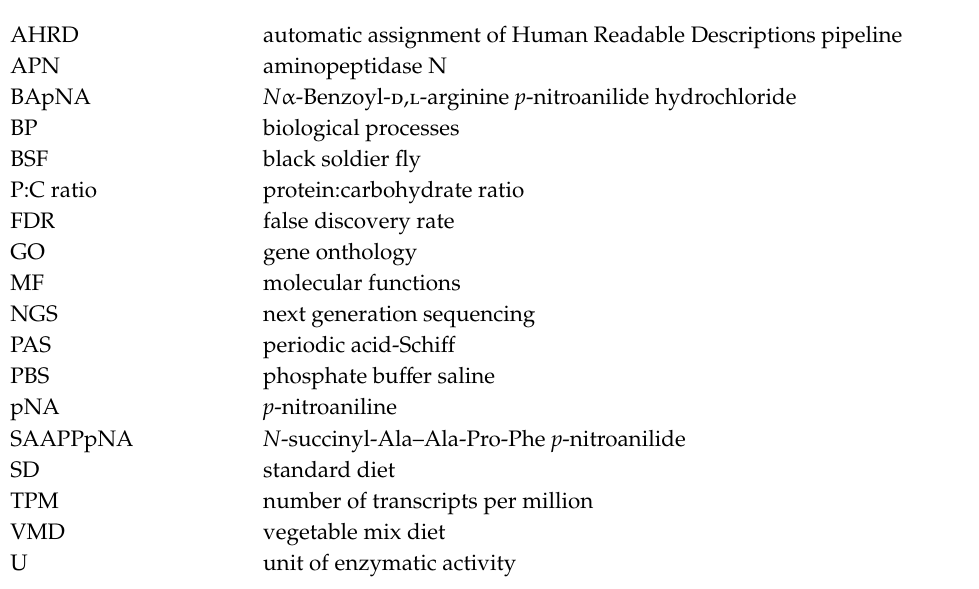
Table S3. Functional annotation of the transcriptome using GO. Table S4. Expression levels of all transcripts